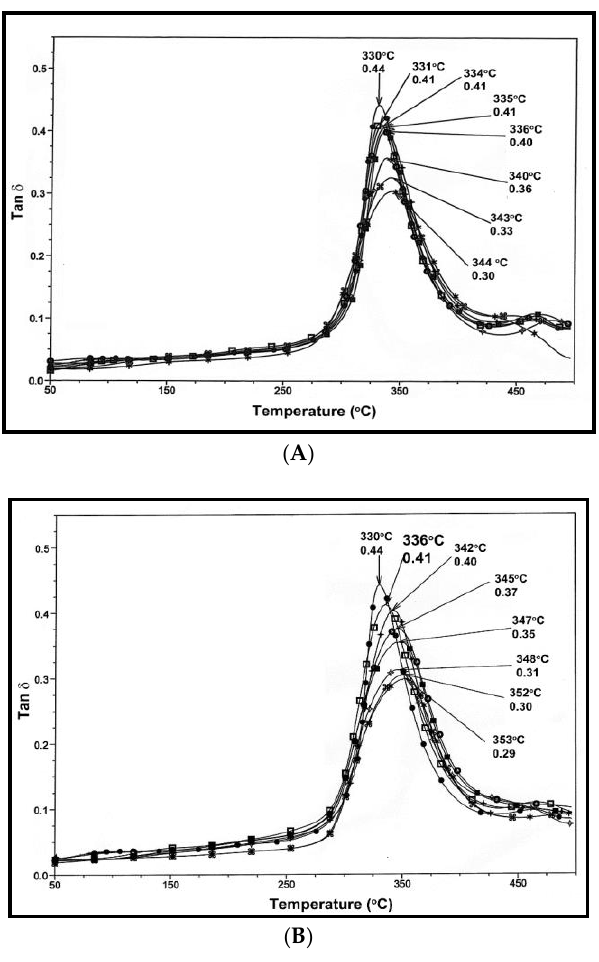
Figure 5. Temperature variation of tan δ: Ar-CNT-P ( A ) and AR-CNT-C ( B ) composites; CNT wt %: 0 ( ), 0.5 (□), 1 ( ), 1.5 ( ), 2 ( ■ ), 2.5 ( ), 5 ( ), 7.5 ( * ).